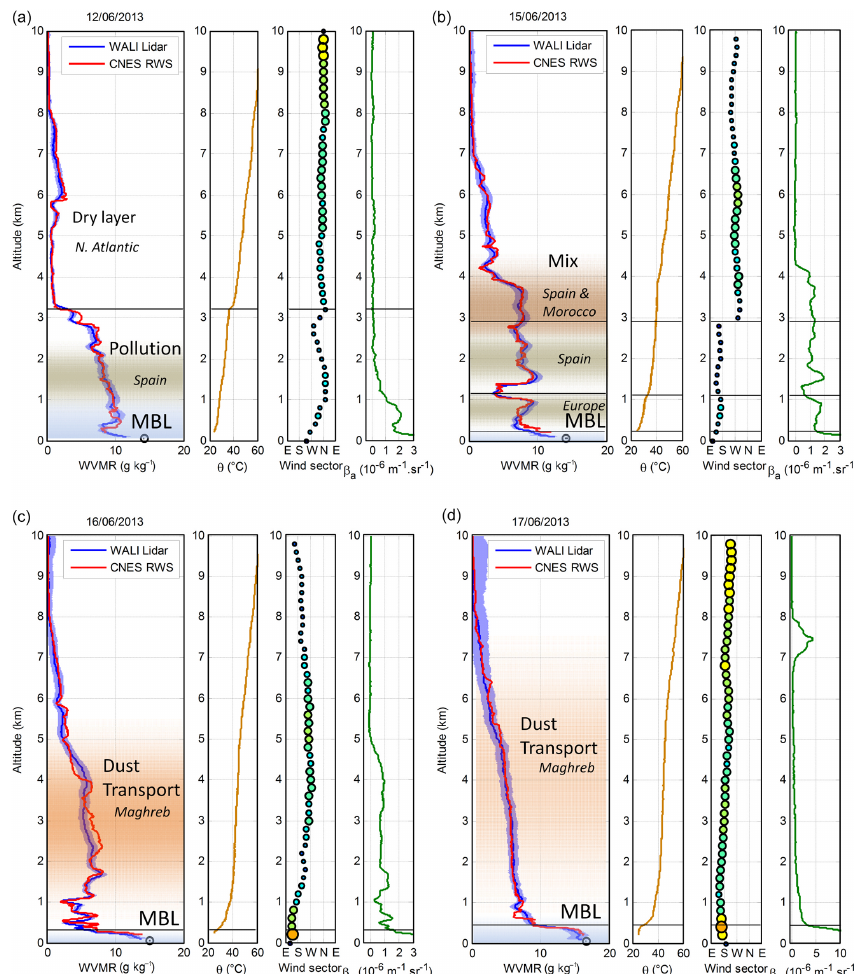
Figure 4. Comparison of lidar WVMR measurements to four rawinsoundings performed from Sant-Lluís air field on the evenings of (a) 12 June, (b) 15 June, (c) 16 June and (d) 17 June 2013 (approximately 21:00 to 23:00LT), under varied aerosol loads and atmospheric water contents. The red line is the radiosonde-derived WVMR and the blue line is that obtained by lidar, with its standard deviation repre- sented as a blue-shaded area. The black circle at zero altitude indicates WVMR as measured on the ground. Potential temperature θ , wind sector and velocity (shown as circle size and colour, measured by the radiosonde), as well as profiles of aerosol backscatter coefficient β a (measured by the lidar), are also given for reference. Layer boundaries as indicated by wind shears and strong potential temperature gradients are denoted by black lines. Origins and contents of air masses as deduced by back trajectories (HYSPLIT; Draxler and Rolph, 2015) are given in plain text. The lidar integration time is equal to the balloon ascent, i.e. approximately 40min. MBL stands for marine boundary